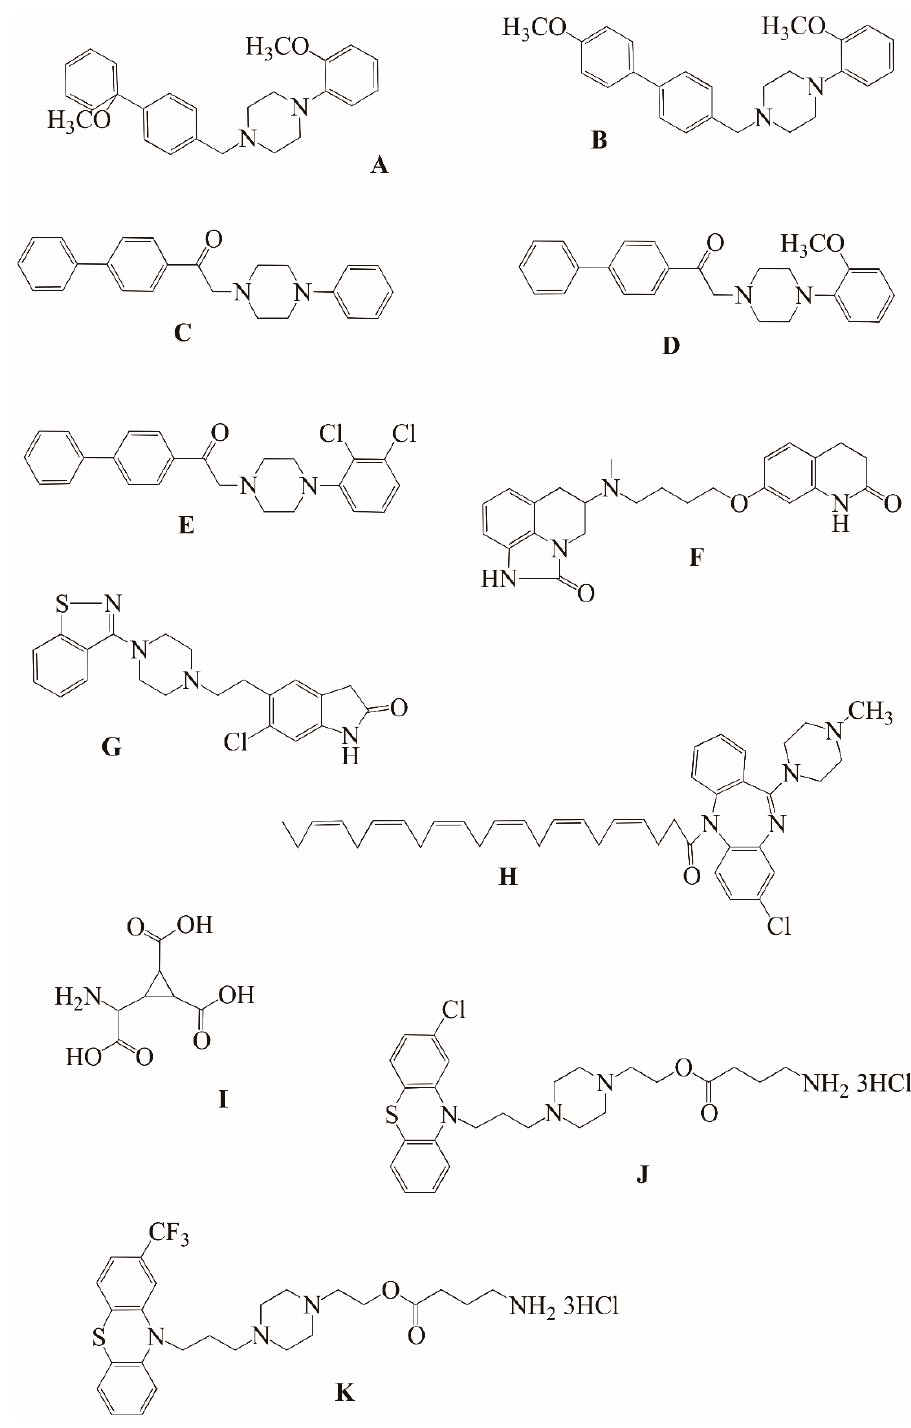
Figure 5. Structures of designed hybrid compounds with anti-schizophrenic properties. ( A – E ) Series of conjugates containing the biphenyl pharmacophore and arylpiperazine-like pharmacophore; ( F ) sumanirole–aripiprazole hybrid; ( G ) ziprasidone; ( H ) clozapine–docosahexaenoic acid; ( I ) DCG-IV; ( J , K ) GABA-based conjugates (AN168 and AN187, respectively). The hybridization of both antipsychotic agents and a GABA agonist (including GABA itself), either fused or covalently bound via a carboxylic acid ester bond, also affords new molecules that were found to provide therapeutic effects associated with GABA systems (e.g., mood stabilization and relaxation). In addition, a reduction of side effects induced